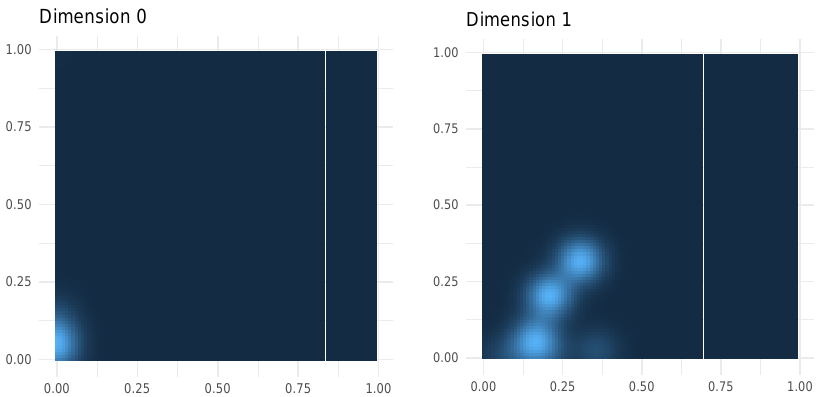
Figure 6. Persistent images of the barcode shown in Figure 5 in dimension 0 ( left ) and dimension 1 ( right ). Here, δ min = 0, δ max = 1, h = 0.05, and p =